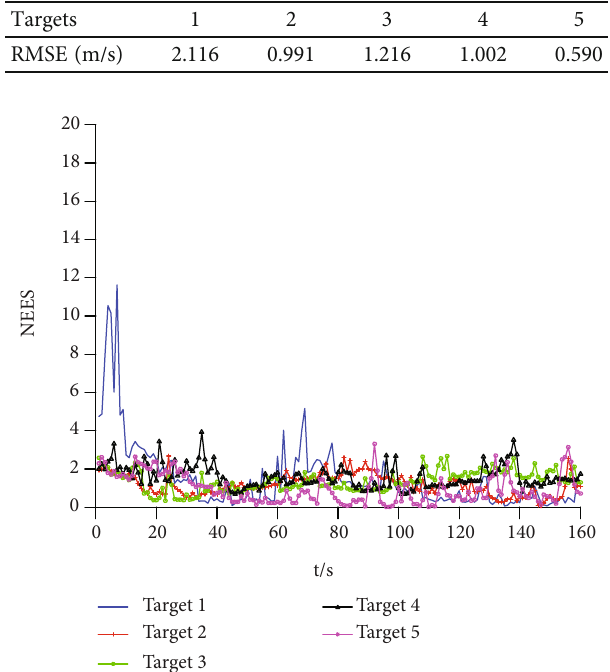
Table 4: The average velocity RMSE of fi ve targets.